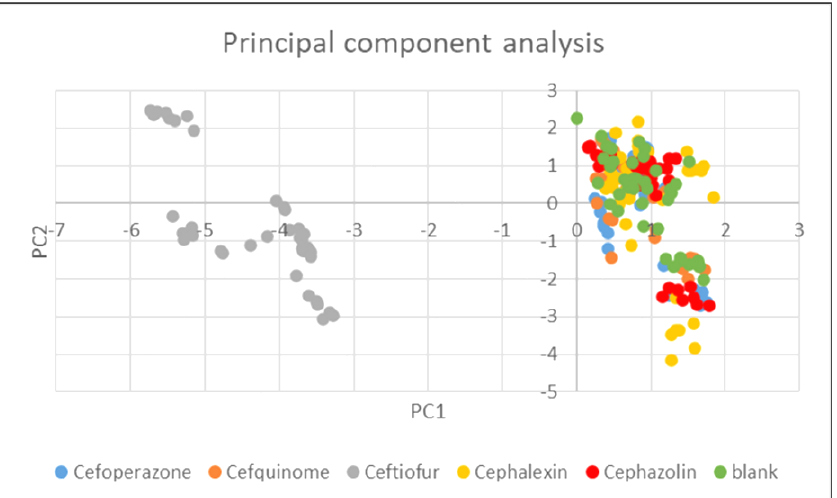
Figure 4. Principal Component Analysis: Effect of cephalosporins on pH value, titratable acidity value, and organic acids concentration at the end of fermentation.